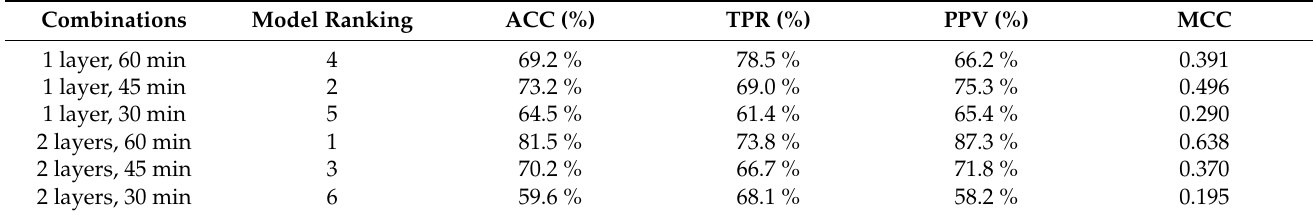
Table 5. Performance of Deep ‐ IDH models using different hidden layers and data lengths. Combinations